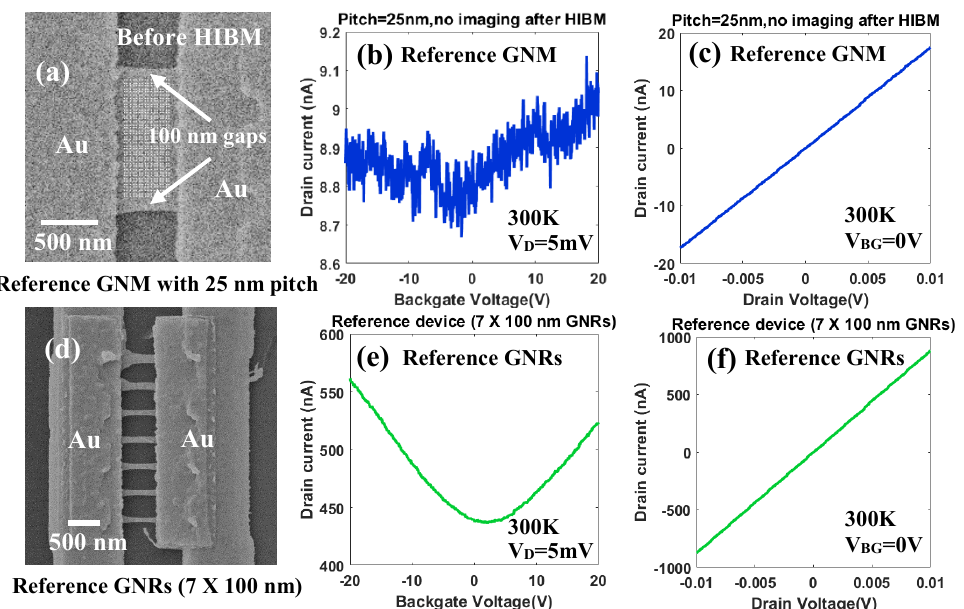
Figure 8. ( a ) One reference GNM device with 25 nm pitch. After HIBM, no imaging. ( b ) The V BG dependence of the I D with fixed V D = 5 mV at 300 K for the GNM device in (a). ( c ) The V D dependence of the I D with fixed V BG = 0 V at 300 K for the GNM device in (a). ( d ) One reference GNRs device with 7 parallel 100 nm width suspended GNRs. ( e ) The V BG dependence of the I D with fixed V D = 5 mV at 300 K for the GNM device in (d). ( f ) The V D dependence of the I D with fixed V BG = 0 V at 300 K for the GNM device in (d).